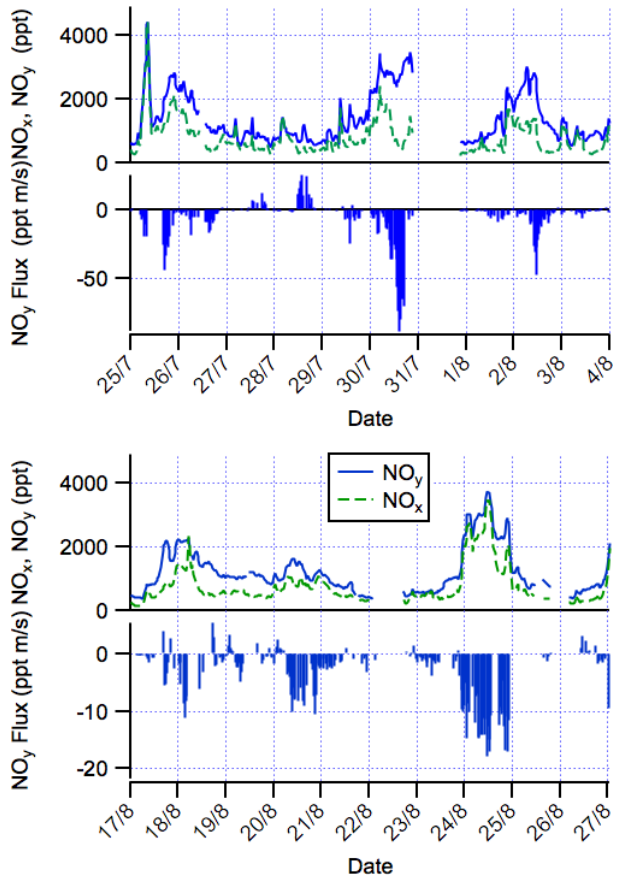
Fig. 7. Example 10day time series for NO x and NO y mixing ratios and eddy covariance NO y fluxes at (a) PROPHET and (b)